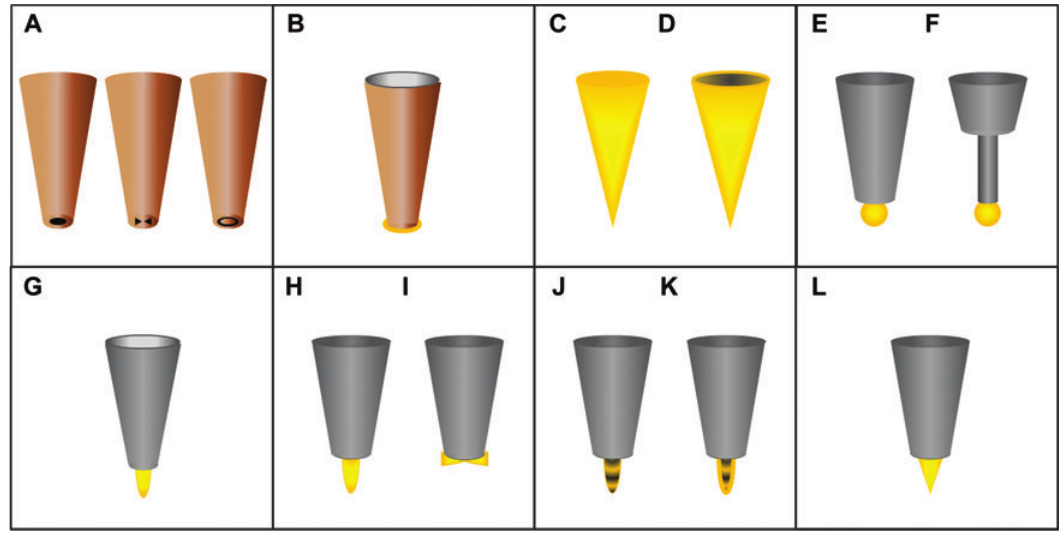
Figure 1 Overview of different types of NSOM probes. Aperture probe tips: (A) metalized (typically with aluminum) dielectric tips with circular, bowtie-, or ring-shaped apertures, (B) metalized dielectric tip with hole-aperture in a gold metal disc. Apertureless probe tips: (C) sharp metal wire tip, (D) sharp dielectric tip with thin metal coating, (E) colloidal metal particle attached to a scanning probe, (F) nanowire tip grown below a metal particle, (G) colloidal nanorod attached to a hollow tip by capillary force, (H) vertical nanorod (mostly on aperture probes) and (I) bowtie antenna crafted at the tip by focused ion beam milling, (J) metal tip grown by EBID or IBID, (K) metal-coated tip grown by EBID or IBID, (L) metal nanostructure or nanocone defi ned by induced deposition mask lithography. (Sketches courtesy of B. Schr ö ppel, NMI Reutlingen, Germany, and M.